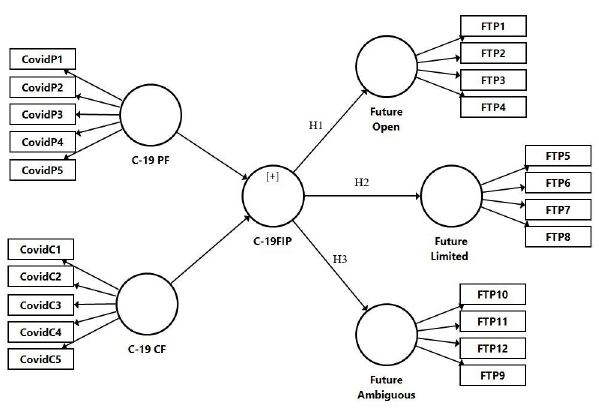
Fig 3. Structural model.